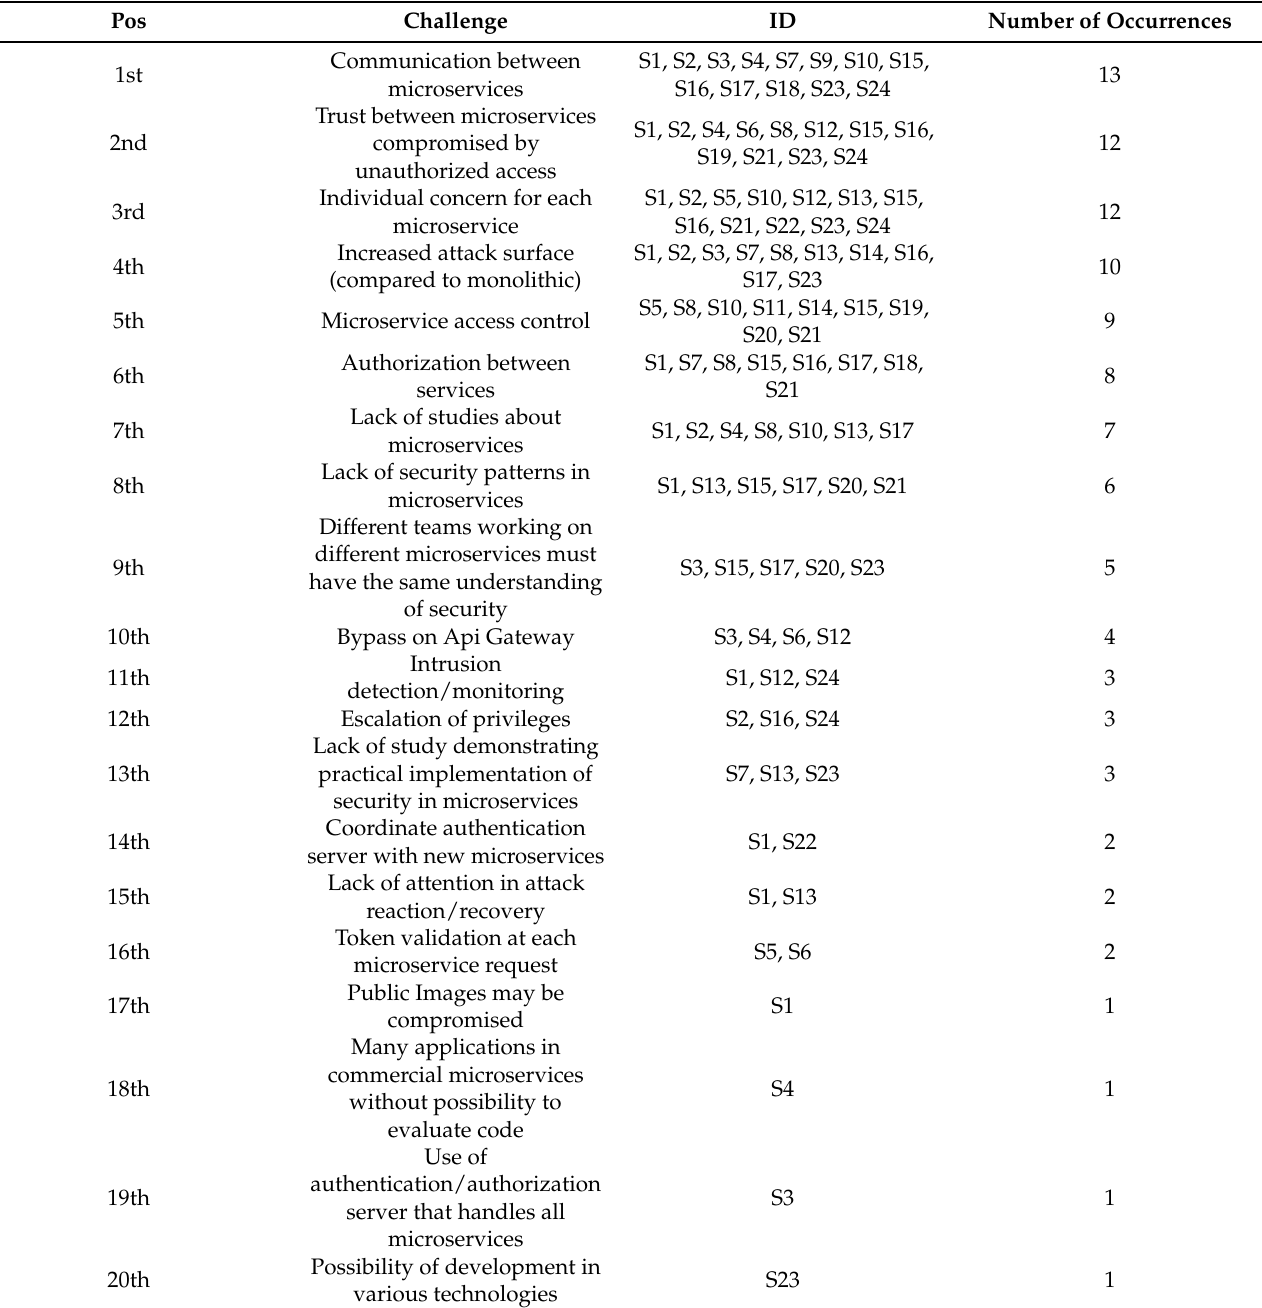
Table 4. Challenges related to authentication and authorization in